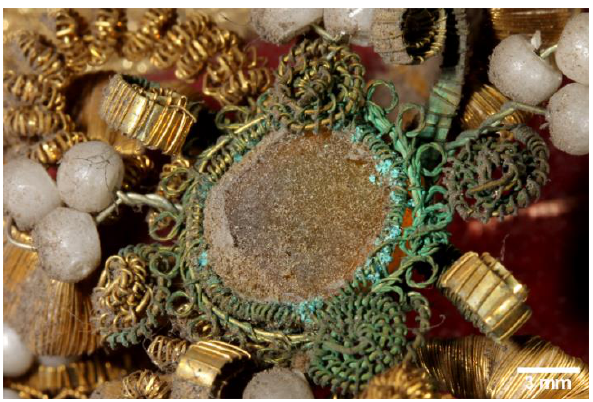
Figure 4. Corrosion caused by a glass cabochon of the reliquary of the Saints Quirinus and